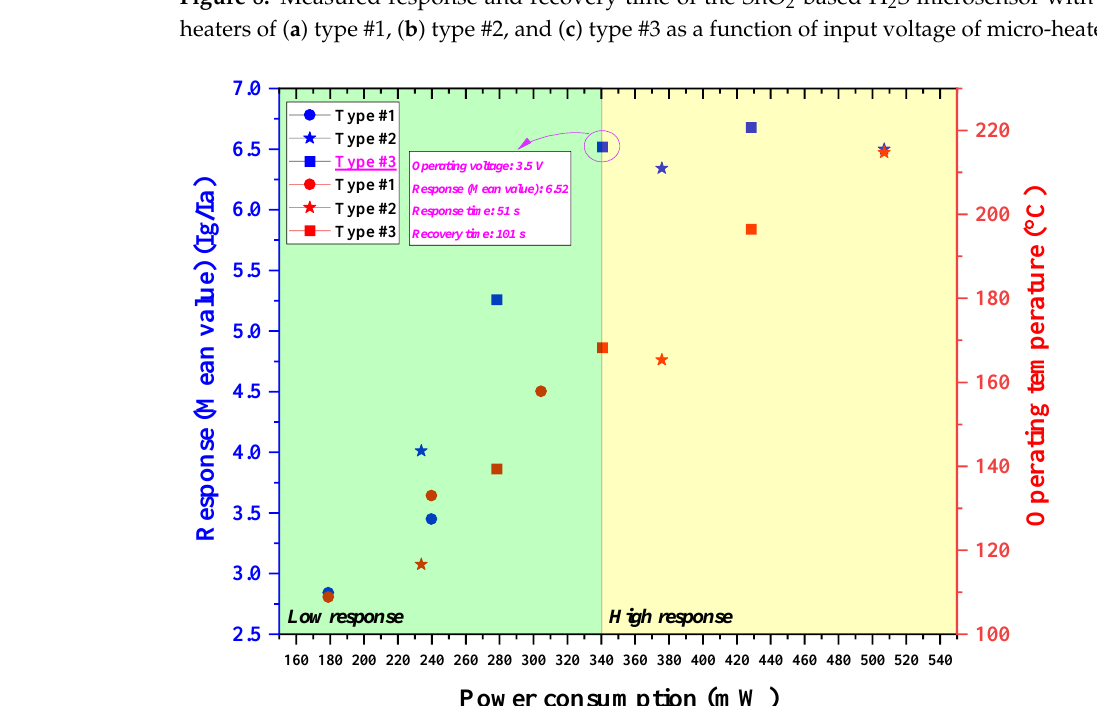
Figure 9. Measured response and expected operating temperature of the SnO2-based H2S microsensor with micro-heaters of type #1 – #3 as a function of power consumption.